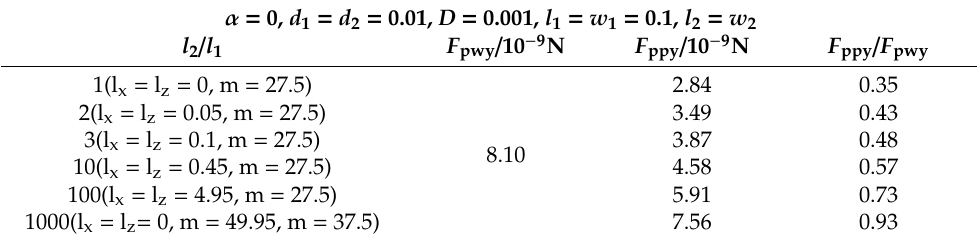
Table 1. Comparison of van der Waals force calculated based on plate-wall model and the present model.